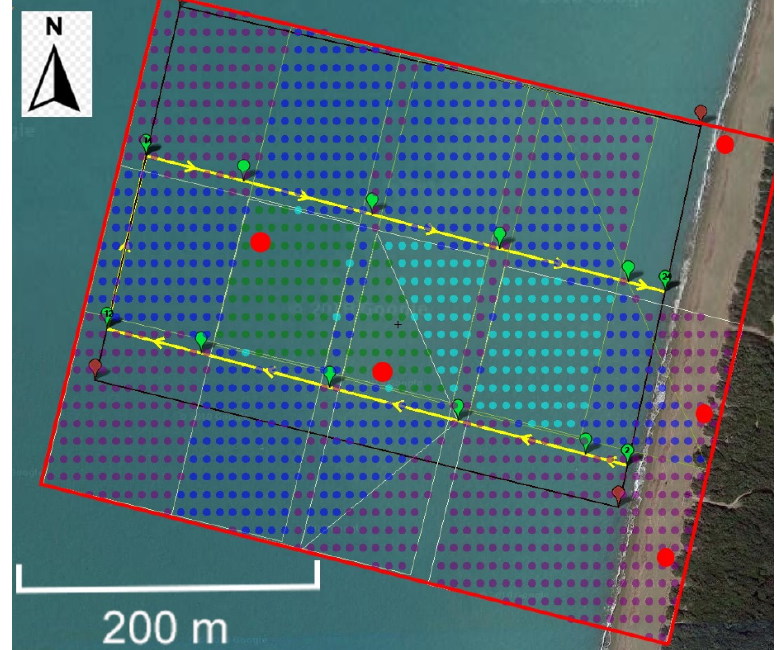
Figure 5. UAV flight plan in the study area, with the position of the two buoys and three Ground Control Points (GCPs) on the beach marked by red circles.